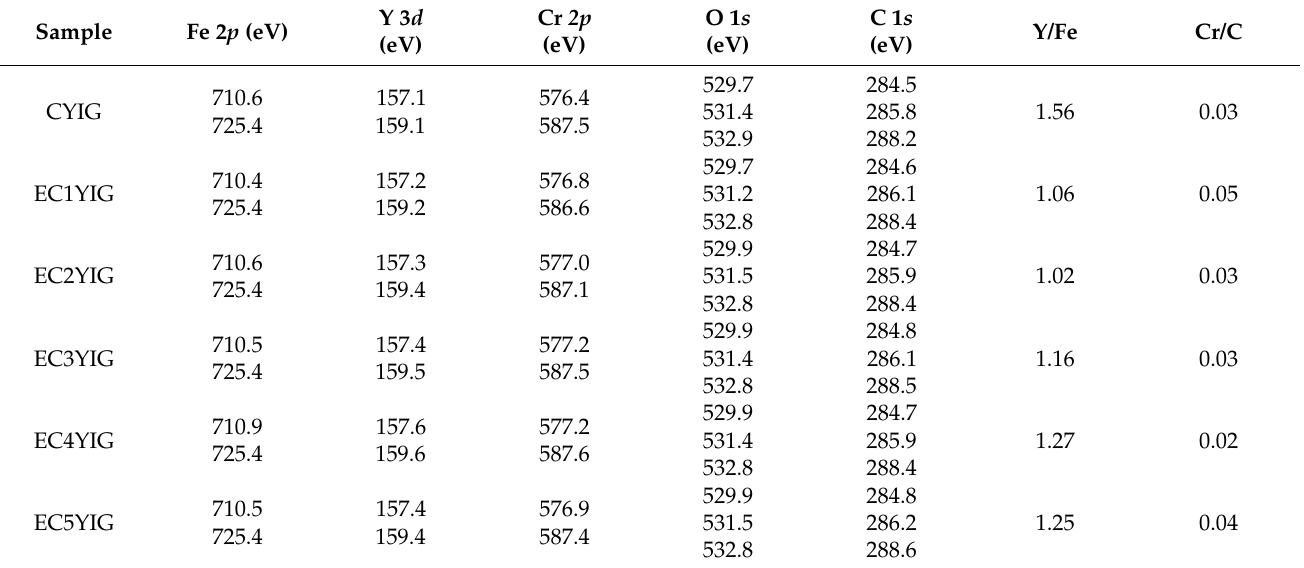
Table 3. Binding energies values (in eV) of the constituent elements of the studied catalysts and Y/Fe and Cr/C atomic ratios determined by